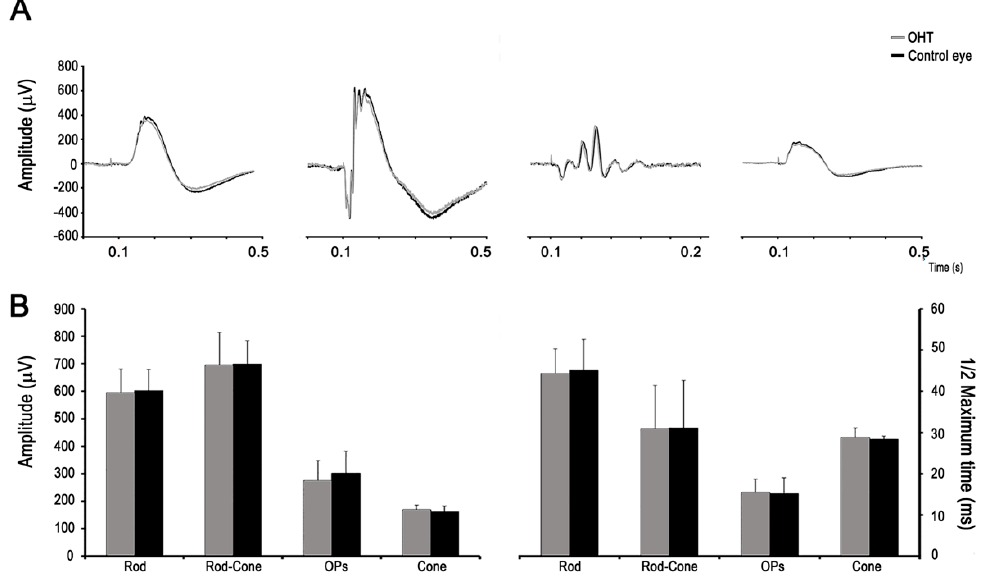
Figure 4. Effect of chronic IOP elevation on the outer retina function. ( A ) Normal scotopic (rod) and photopic (cone) full-field electroretinogram (ERG) recordings from a representative animal (hypertensive eye in gray traces and control eye in black) are shown. ( B ) Bar graphs showing the amplitude and implicit time responses for the dark-adapted (rod, combined rod-cone, and oscillatory potentials (OP)) and light-adapted (cone responses) ERG responses. There were no significant differences in the amplitudes and implicit times of the various ERG components between the hypertensive and control fellow eyes.